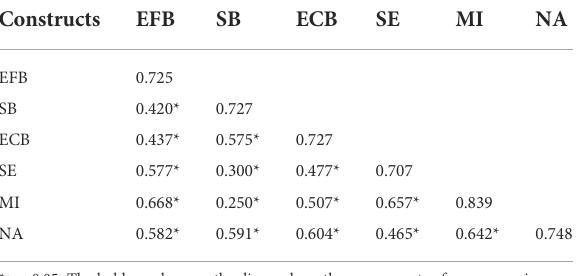
TABLE 2 Correlation matrix of the